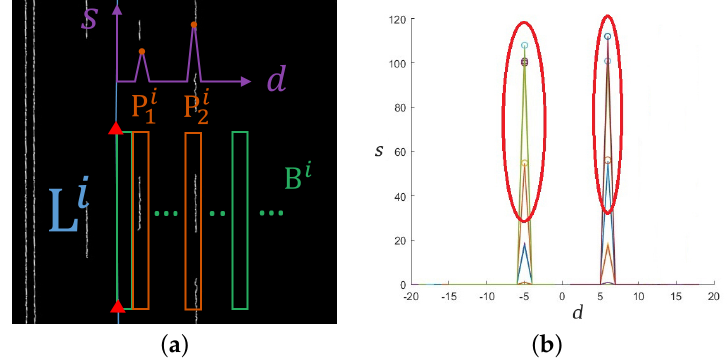
Figure 12. ( a ) The white pixels are the skeletonized lane markings. The red triangles are the trajectory points, and they are connected by line segment L i . The green boxes represent the moving buffer B i . The purple line indicates the change in s with respect to d of B i . In addition, the two orange boxes are ( j = 1,2 ) . ( b ) Each colored polyline represents the change in s with respect to d of the peak buffers P i j each B i ( i = 1,2, . . . , n − 1 ) . In the figure, two groups are formed as indicated by the red ellipses, and the pixels in the peak buffers of a group are on the same lane